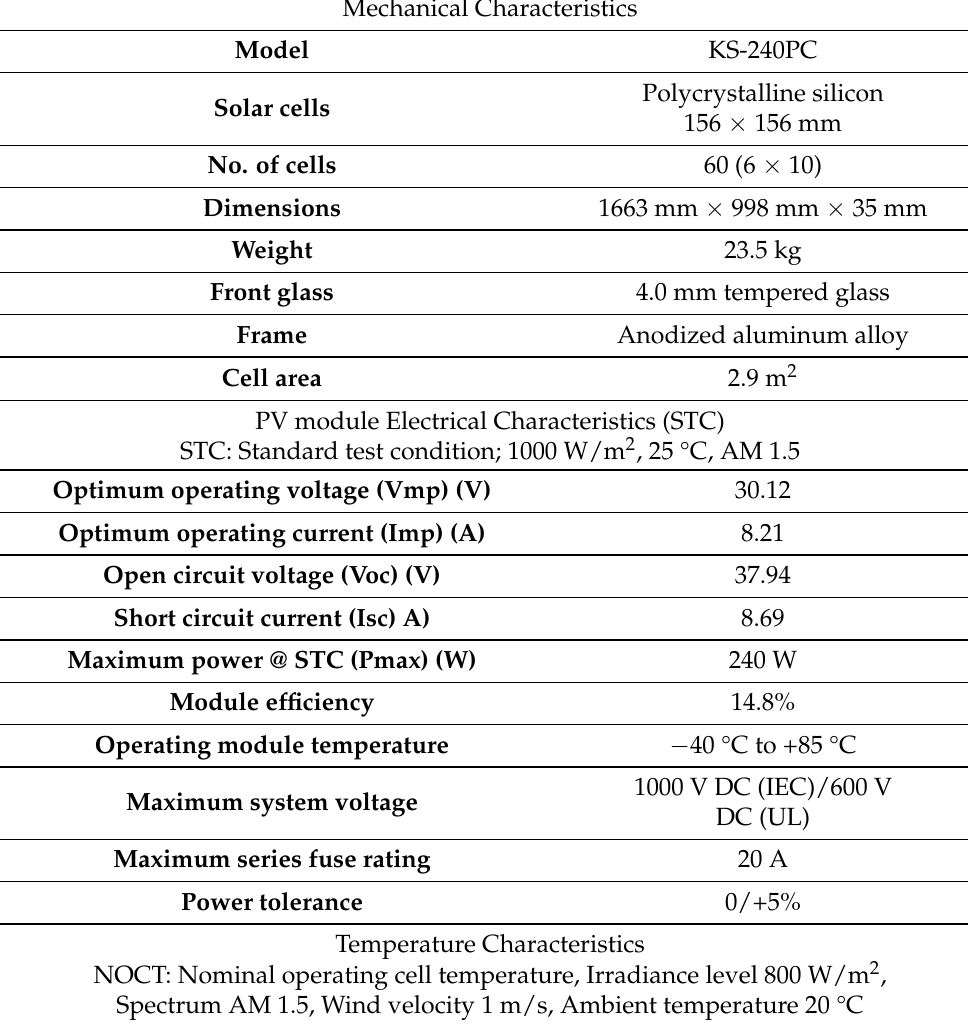
Table 2. PV Array Parameters and